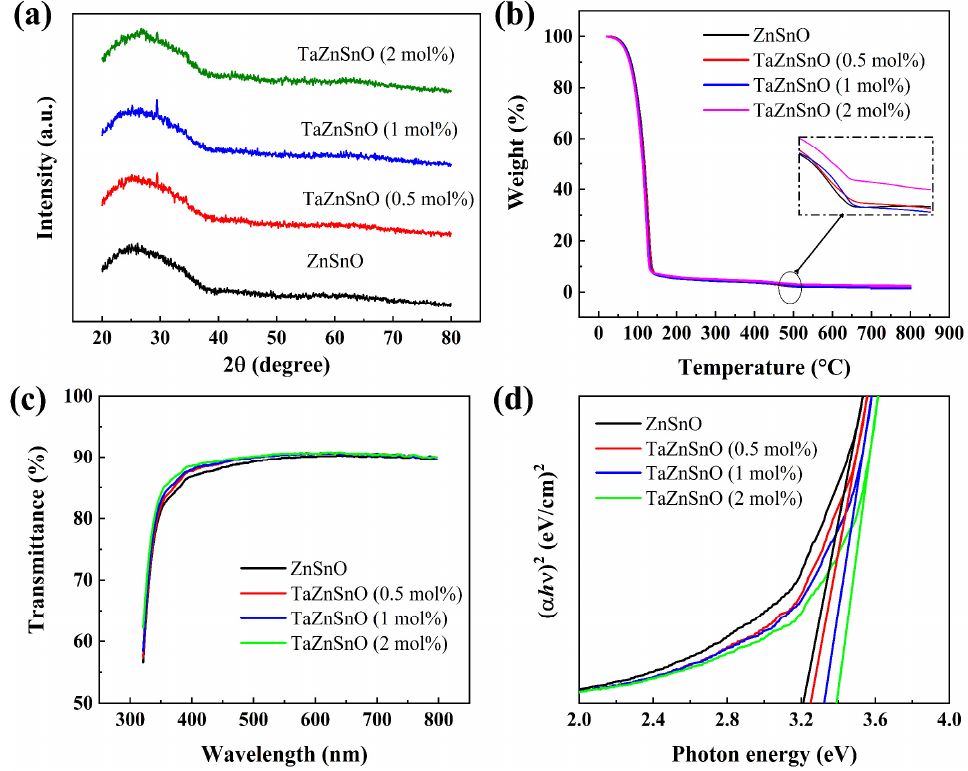
Figure 2. ( a ) GIXRD pattern, ( b ) TGA curve, ( c ) optical transmittance spectra, and ( d ) optical bandgap of TaZnSnO thin films with different Ta 5+ doping concentrations.